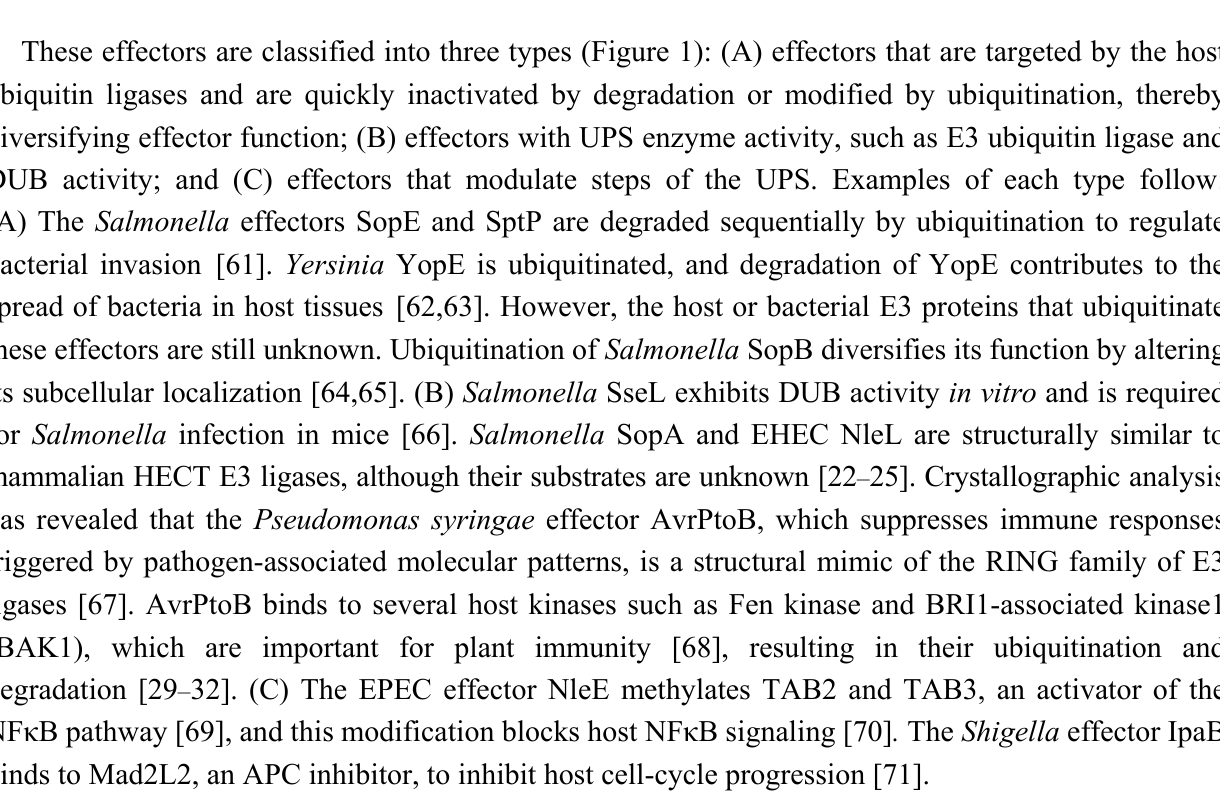
Figure 1. Bacterial effectors manipulate the host ubiquitin-proteasome system (UPS). After translocation into host cells, several effectors (black squares) target the host’s